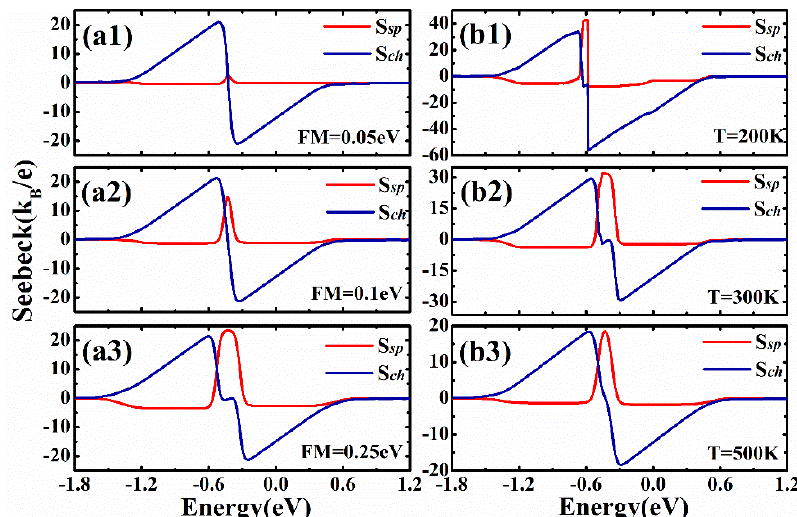
Figure 6. The effects of exchange splitting strength and temperature on the spin-dependent Seebeck coefficients. The gate voltages were applied on both edges and all the parameters are the same as in Figure 4. ( a1 – a3 ) The spin and charge Seebeck coefficients for k B T = 0.03 | t 1 | and M = 0.05 eV,0.1 eV, 0.25 eV. ( b1 – b3 ) The spin and charge Seebeck coefficients for M = 0.184 eV and T = 200 K, 300 K, 500 K.